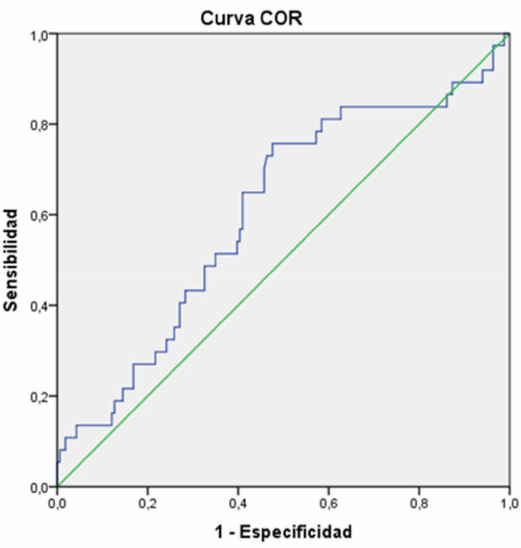
Figure 4. ROC curve: relationship between less weight gain in the first 28 days (g/kg/day) and risk of short stature ( − 2 SD).